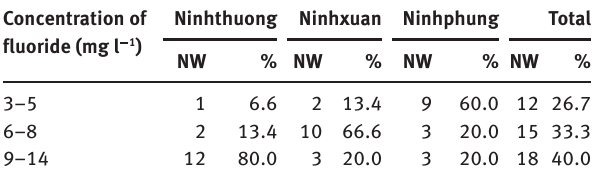
Table 6: Fluoride concentration in surveyed water-wells. Concentration of